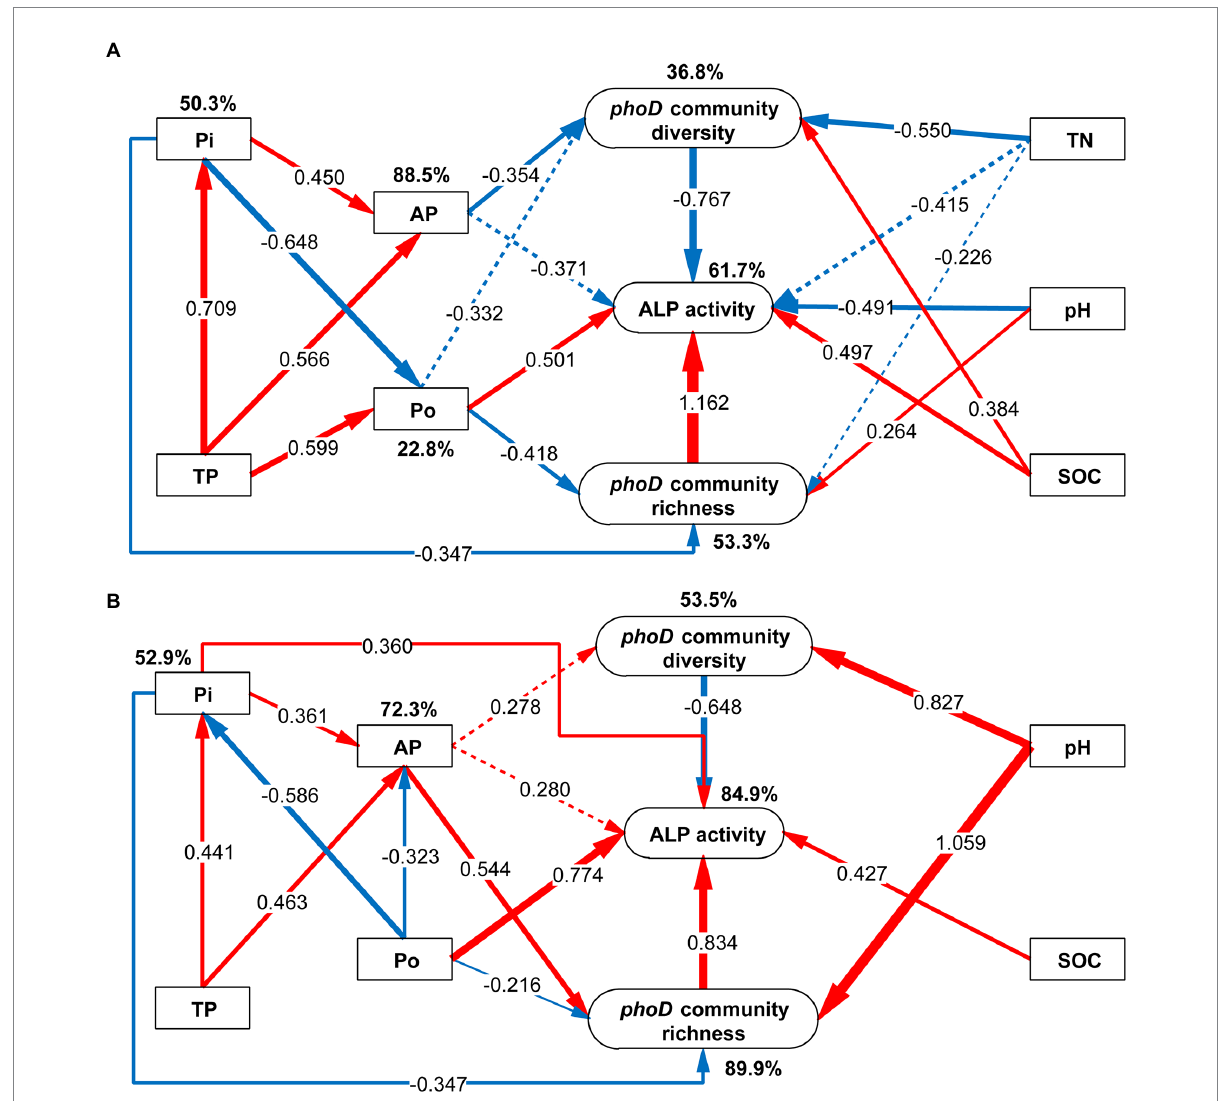
FIGURE 8 Structural equation model (SEM) of the diversity and richness of phoD -harboring bacterial community, alkaline phosphatase (ALP), and soil properties under different phosphorus fertilizer treatments. (A) Under phosphate fertilizer treatment, the SEM parameters, including χ 2 = 27.92, df = 18, χ 2/df = 1.551, p = 0.063, GFI = 0.939, and RMSEA = 0.175. (B) Under phosphite fertilizer treatment, the SEM parameters, including χ 2 = 14.37, df = 12, χ 2/df = 1.198, p = 0.278, GFI = 0.994, and RMSEA = 0.105. See Figure 2 for the defined abbreviations. The phoD community diversity and richness were described by Chao1 and Shannon indexes, respectively. The red and blue arrows represent positive and negative effects, respectively. The thickness of the line represents the degree of influence, and the dotted line represents insignificant influence. The value on the line represents standardized path